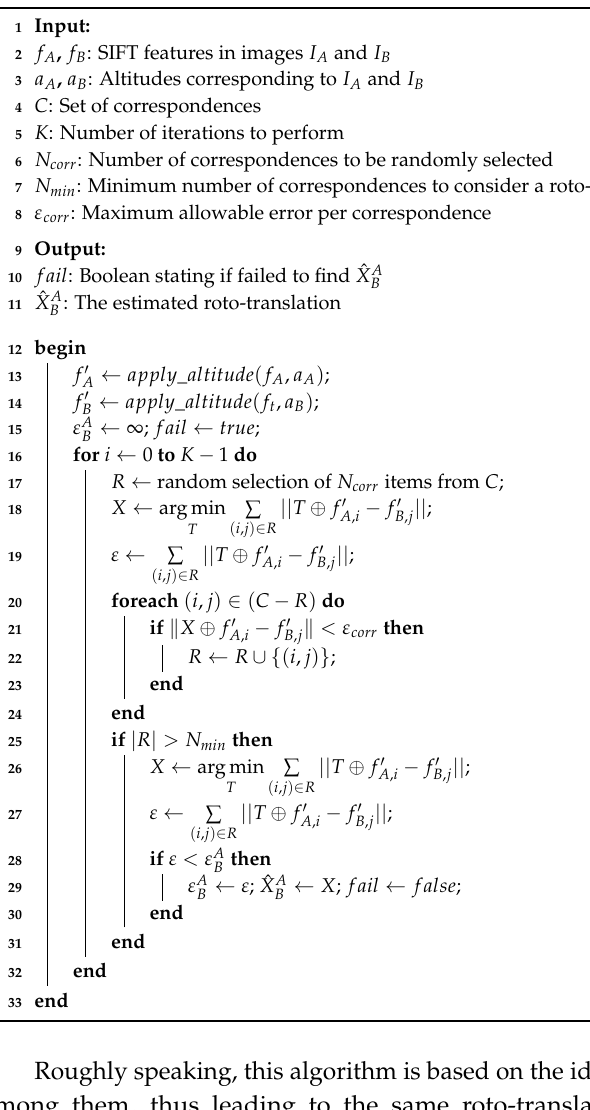
Algorithm 1: RANSAC approach to estimate the motion ˆ X A